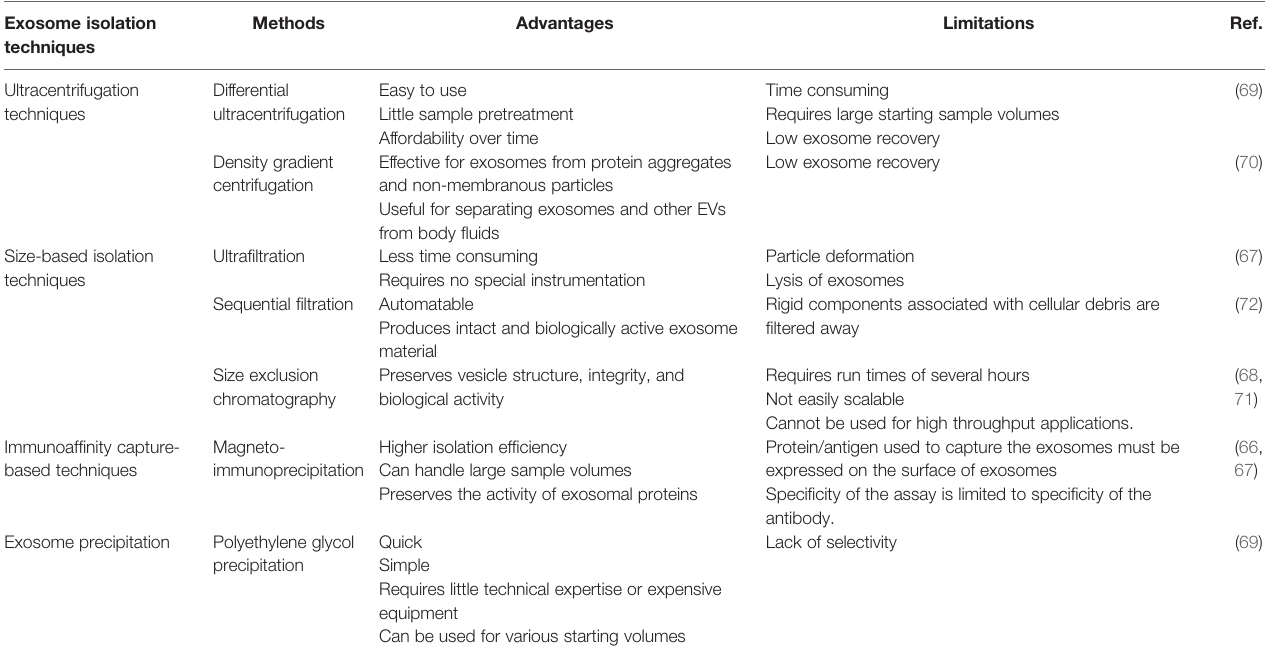
TABLE 1 | Overview of the most popular exosome isolation